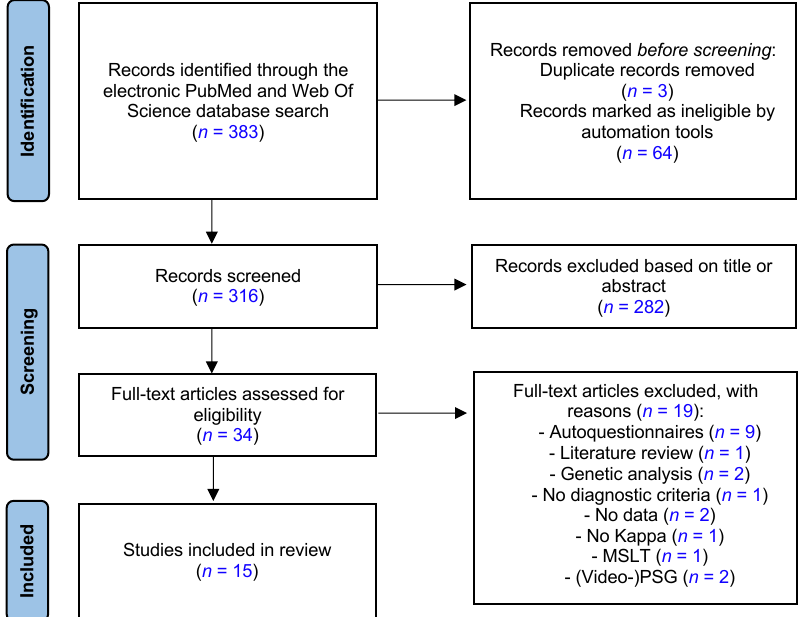
Figure 1. PRISMA flow diagram for the systematic review. MSLT, Multiple Sleep Latency Test